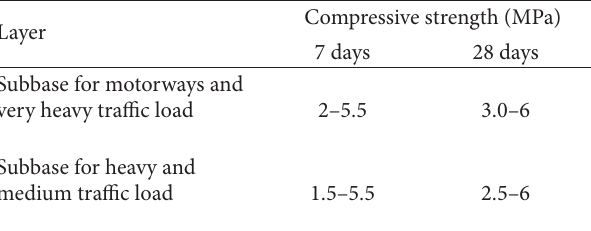
T 3: Compressive strength of cement-stabilized mixture for subbase